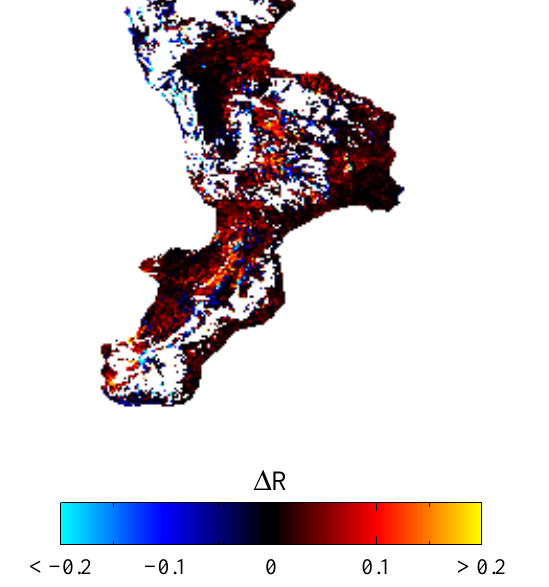
Fig. 10. Increase in correlation coefficient ( 1R ) for the change detection using a seasonal derivation of β relative to the method using a fixed β for the entire year.